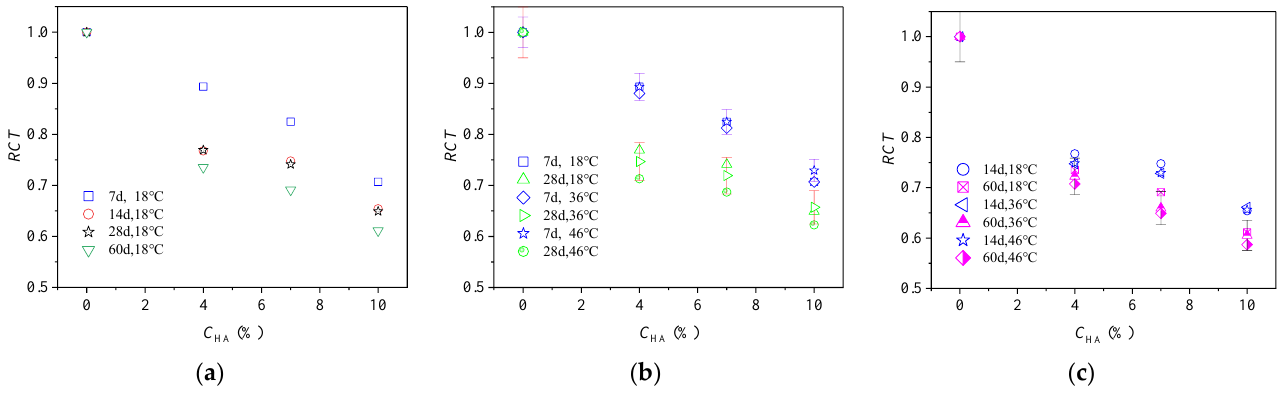
Figure 4. Relationship of RCT - C HA : ( a ) T = 18 °C ; ( b ) 7 d, 28 d curing age; ( c ) 14 d, 60 d curing age.